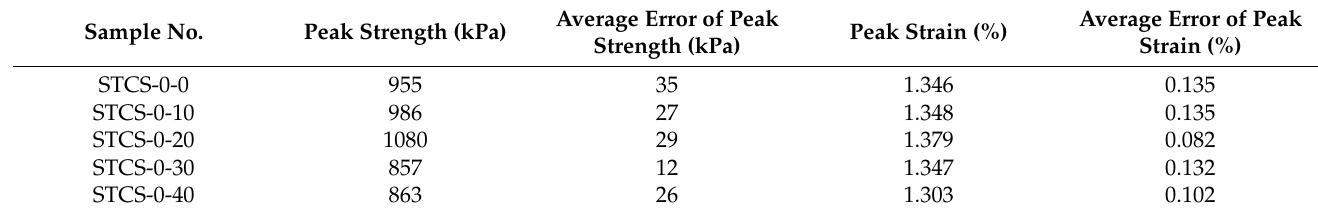
Table 6. Peak strength and peak strain of each group of TCS.